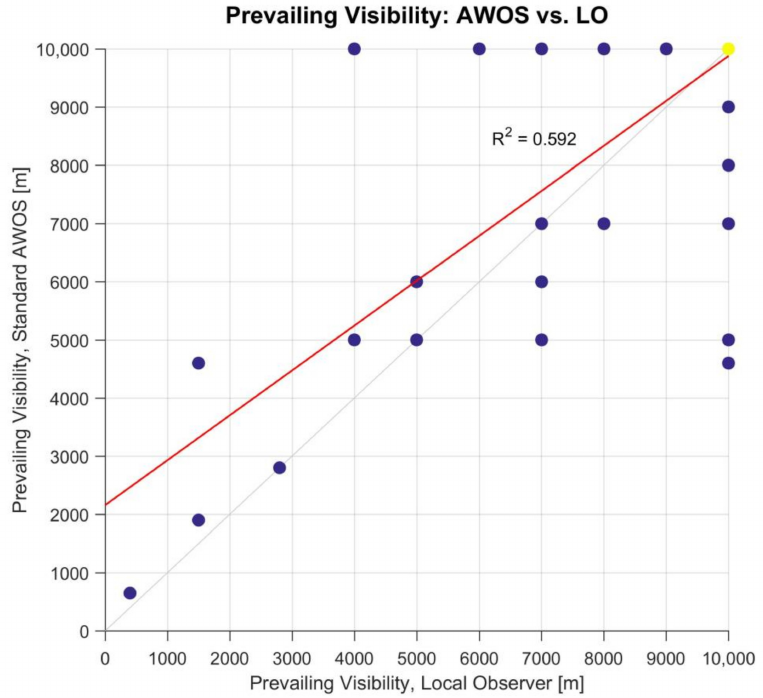
Figure 13. Scatter plot of the values of the prevailing visibility determined by the local observers (LO) and the standard automated sensors (AWOS) at LZTT.